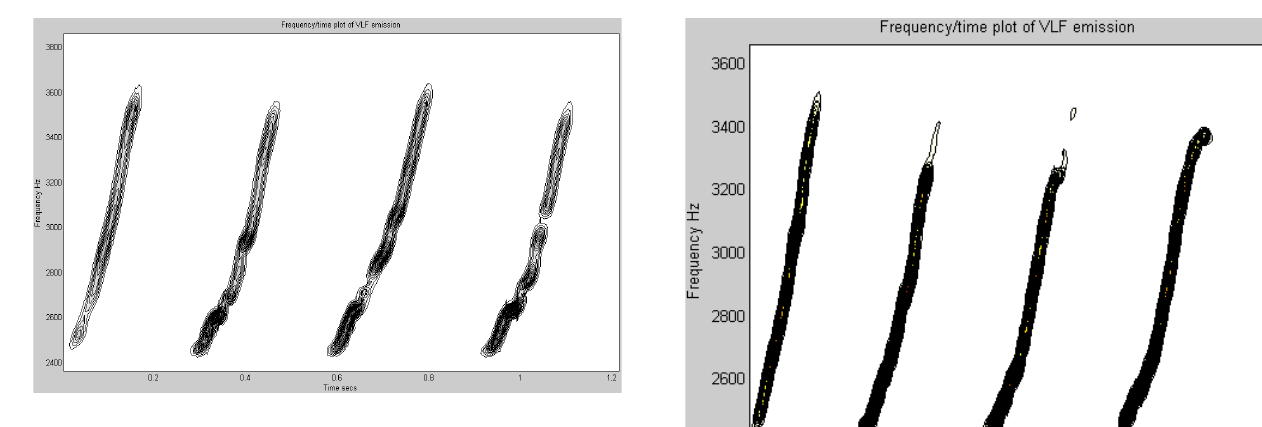
Fig. 7. Spectrogram of the exit wave field data stream for a cold plasma density of Ne=3 electrons/cc. The saturation amplitude is 270pT, the linear equatorial growth rate 1400dB/s, and the local